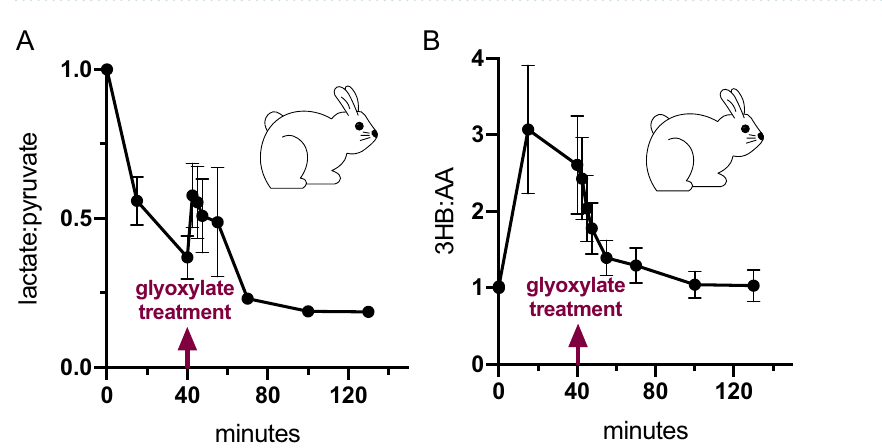
Figure 6. LDH is crucial for glyoxylate metabolism. ( A ) Schematic of glyoxylate and its reactions relative to the TCA cycle. LDH is required for glyoxylate’s oxidation and conversion of pyruvate to lactate. It can also be used for the reduction of glyoxylate. ( B ) Survival of 5 dpf zebrafish 20 h after administration of combinations of the LDH inhibitor GSK2837808A, cyanide, and glyoxylate. Data are presented as mean ± SEM (****p < 0.0001 using one-way ANOVA). There was no significant difference between the untreated control and KCN + glyoxylate and no significant difference between inhibitor + KCN and KCN alone. Each condition had 3 fish per well, N = 3 wells for inhibitor alone, N = 8 for untreated control, N = 7 for KCN alone, N = 4 for KCN + glyoxylate, N = 8 for KCN + glyoxylate + inhibitor, N = 28 for KCN + inhibitor.